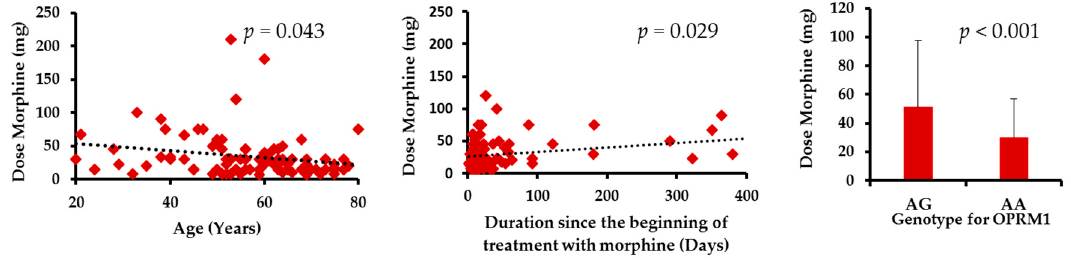
Figure 1. Representation of the variables associated with the morphine doses after multivariate analysis: the mean dose of morphine significantly decreased with age ( p = 0.043) ( a ) but increased with the duration of morphine treatment ( p = 0.029) ( b ); AG patients for the OPRM1 c.118A>G SNP required significantly higher morphine doses than AA patients ( p < 0.001) ( c ).